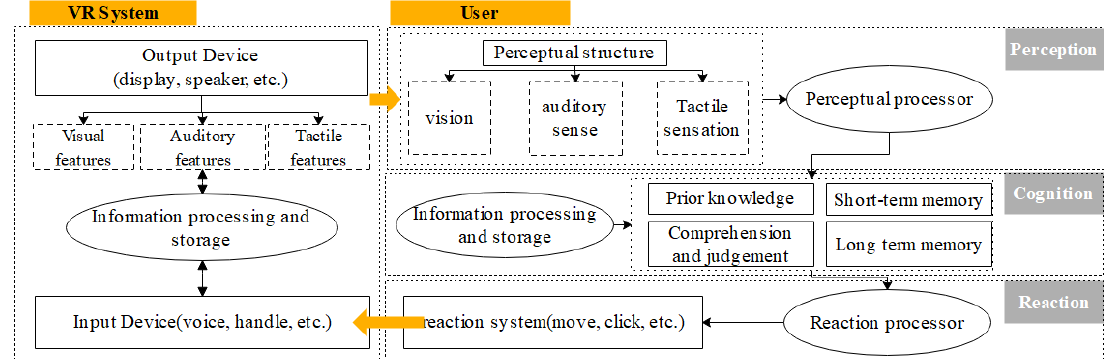
Figure 2. User cognitive information process.